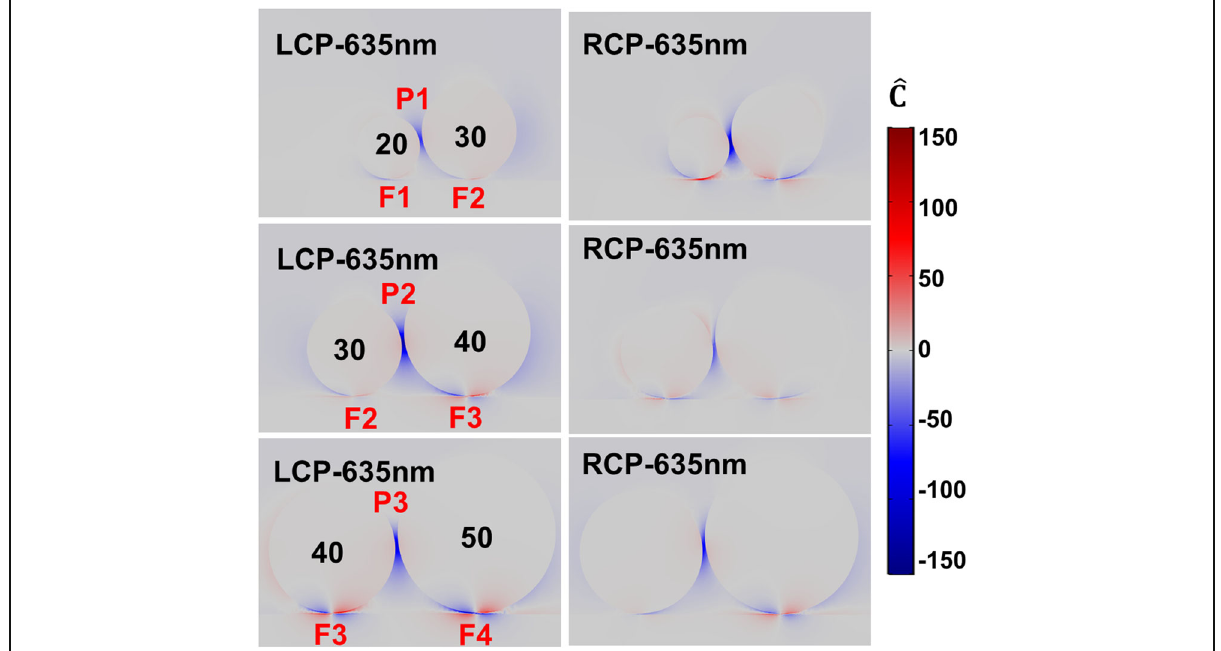
Fig. 5 Chiral near-field enhancement distributions in the gaps between particles and between particles-film at 635 nm resonant peak for LCP and RCP excitation. The diameters of four silver nanospheres in chiral particle chain-film system are respectively marked as 20, 30, 40, and 50 nm. The gaps between different diameter particles and film are respectively labeled as F1, F2, F3, and F4, and the gaps between particles are labeled as P1, P2, and P3,